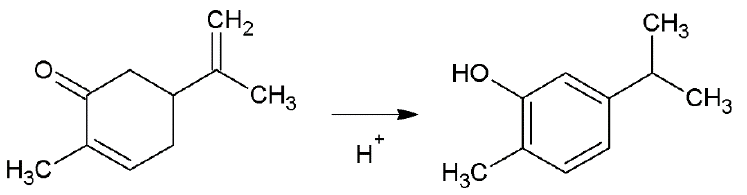
Figure 1. Reaction scheme of isomerization carvone to carvacrol.